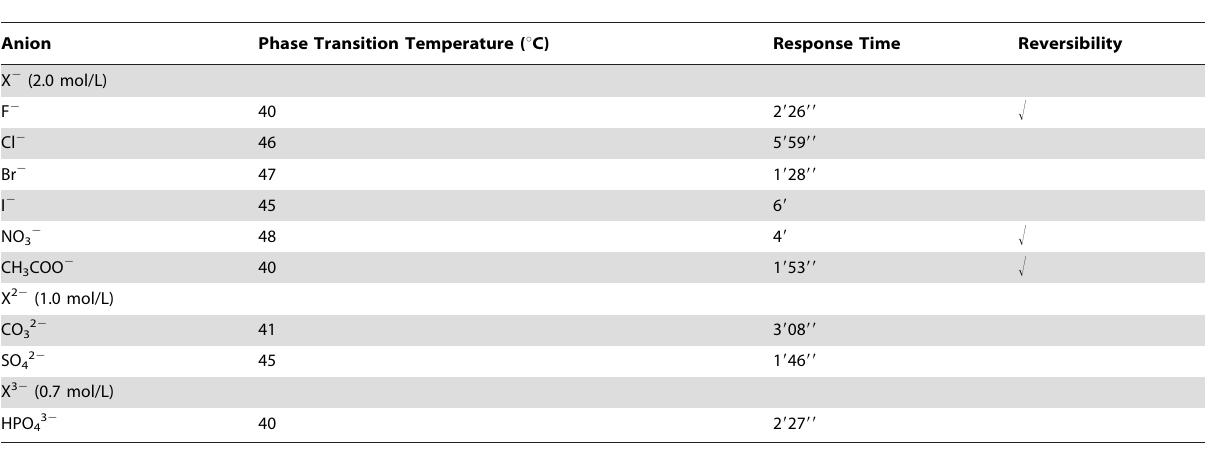
Table 1. Temperature-Sensitive Response for Different Anions Modified CLGNs.